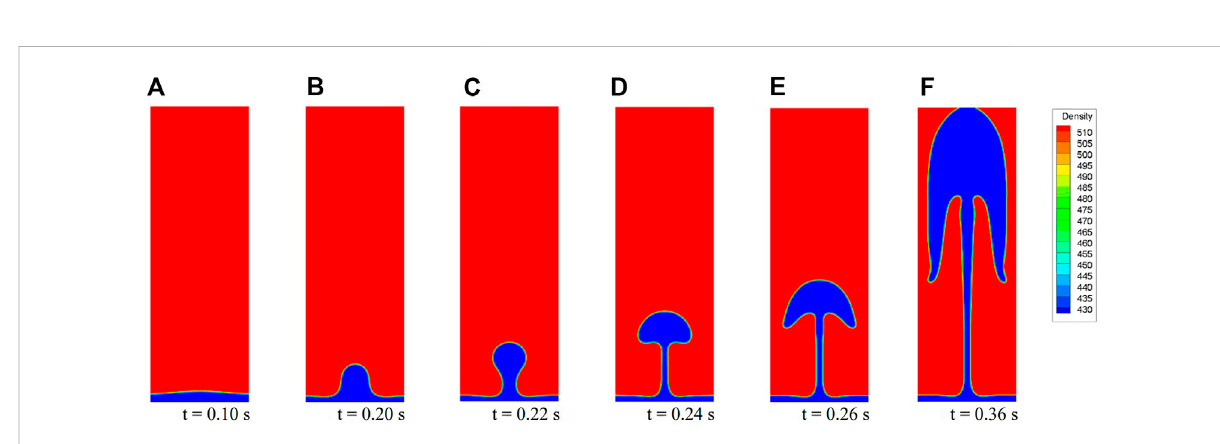
FIGURE 10 Density contours of carbon dioxide at 7.37 MPa with 80 K overheat, at different times.